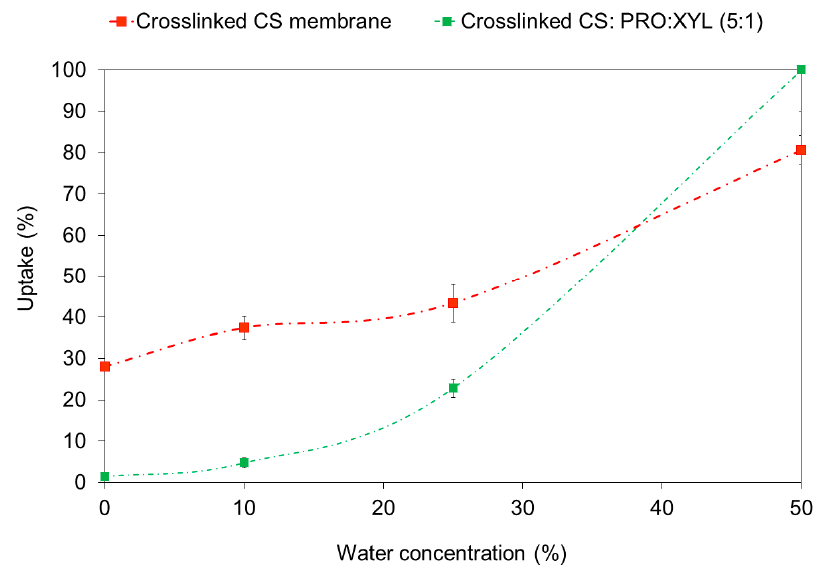
Figure 8. Uptake of CS-DES membranes at di ff erent water concentrations in ethanol (at room tem- temperature). The curves are only guiding the perature). The curves are only guiding the eye.